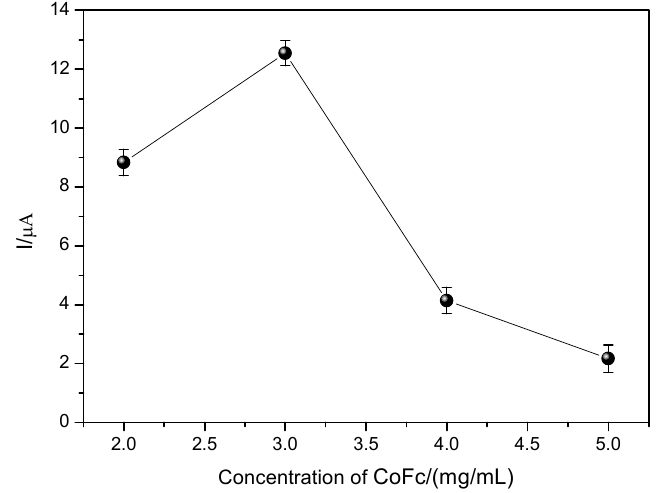
Figure 10. Variation of the Ipa/μA of Ethinyl estradiol as a function of the concentration of Metallic Cobalt Phthalocyanine. Concentration of 175 μmol L −1 of Ethinyl estradiol. Buffer solution Phosphate 0.1 mol L −1 , pH 7.0.